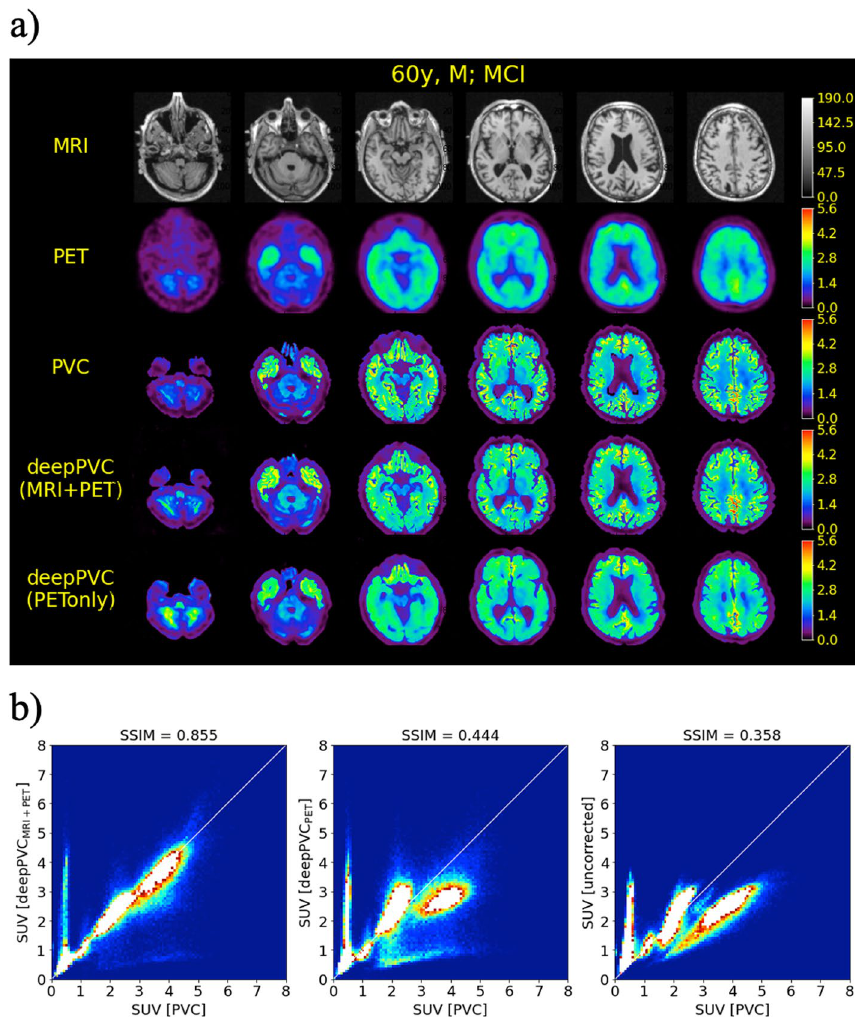
Fig. 4 MR images, SUV maps ( a ), and 2D histograms of the PV-corrected map ( b ) for the representative case of PiB-positive (60 years old; male; MCI). The 2D histograms, left to right, represent maps predicted with deepPVC MRI , deepPVC PET , and uncorrected PET, respectively. The white lines on the histograms indicate + PET perfect correspondence with the real PV-corrected SUV. MCI, mild cognitive impairment; MR, magnetic resonance; PVC, partial volume correction; SUV, standardized uptake